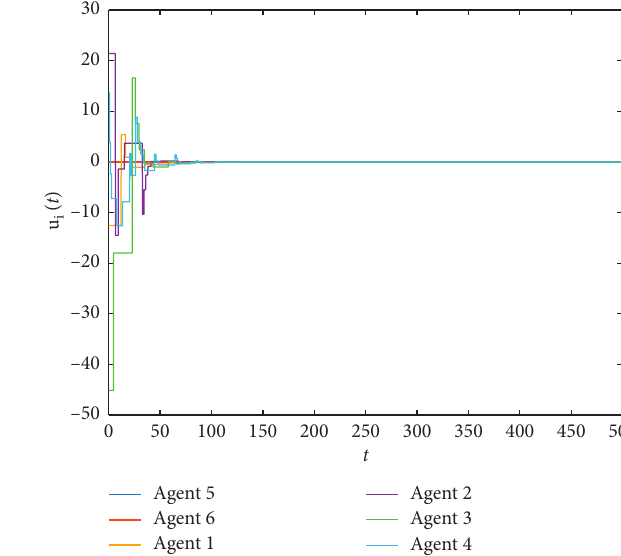
Figure 5: The control inputs for containment control.